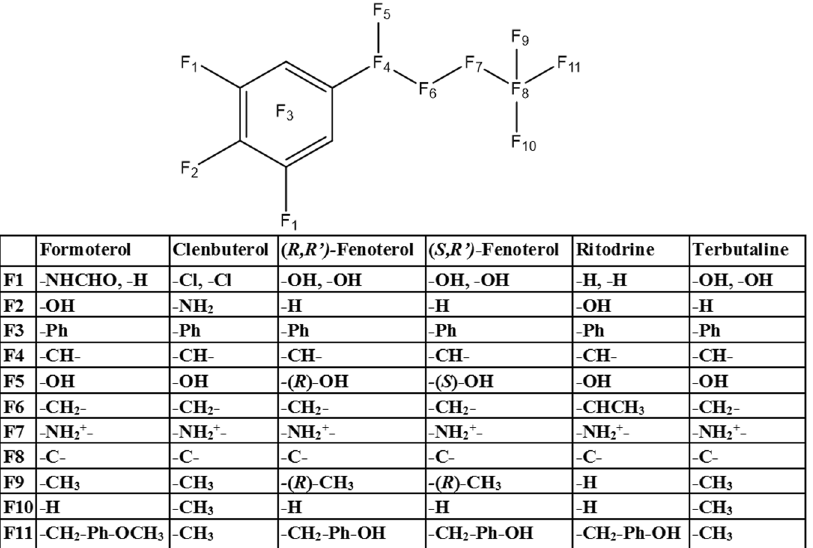
Figure 6. Dividing β 2 AR agonists into chemical groups reveals distinct structural features. Formoterol, clenbuterol, (R,R’)-fenoterol, (S,R’)-fenoterol, ritodrine, and terbutaline were divided into 11 chemical features (F1-F11). Ph- phenyl